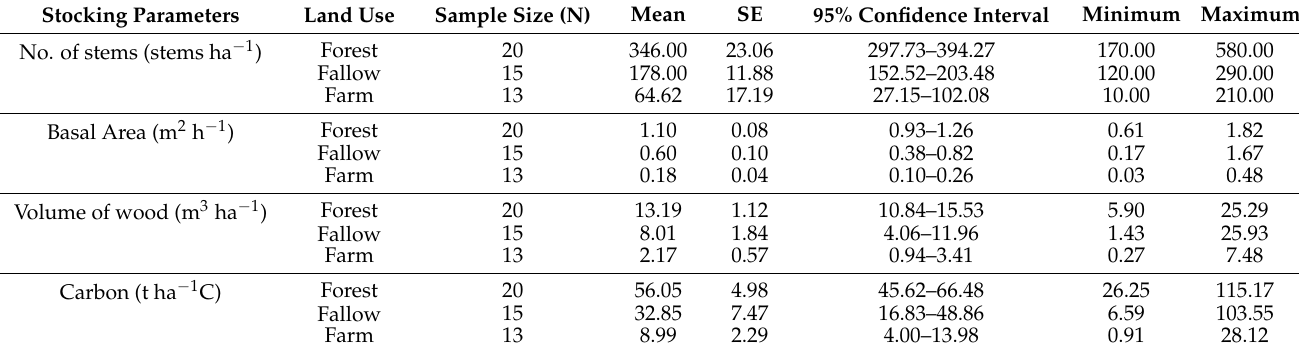
Table 3. Descriptive statistics of stand parameters in the Kolero sub-catchment, Uluguru Mountains, Tanzania. Stocking Parameters